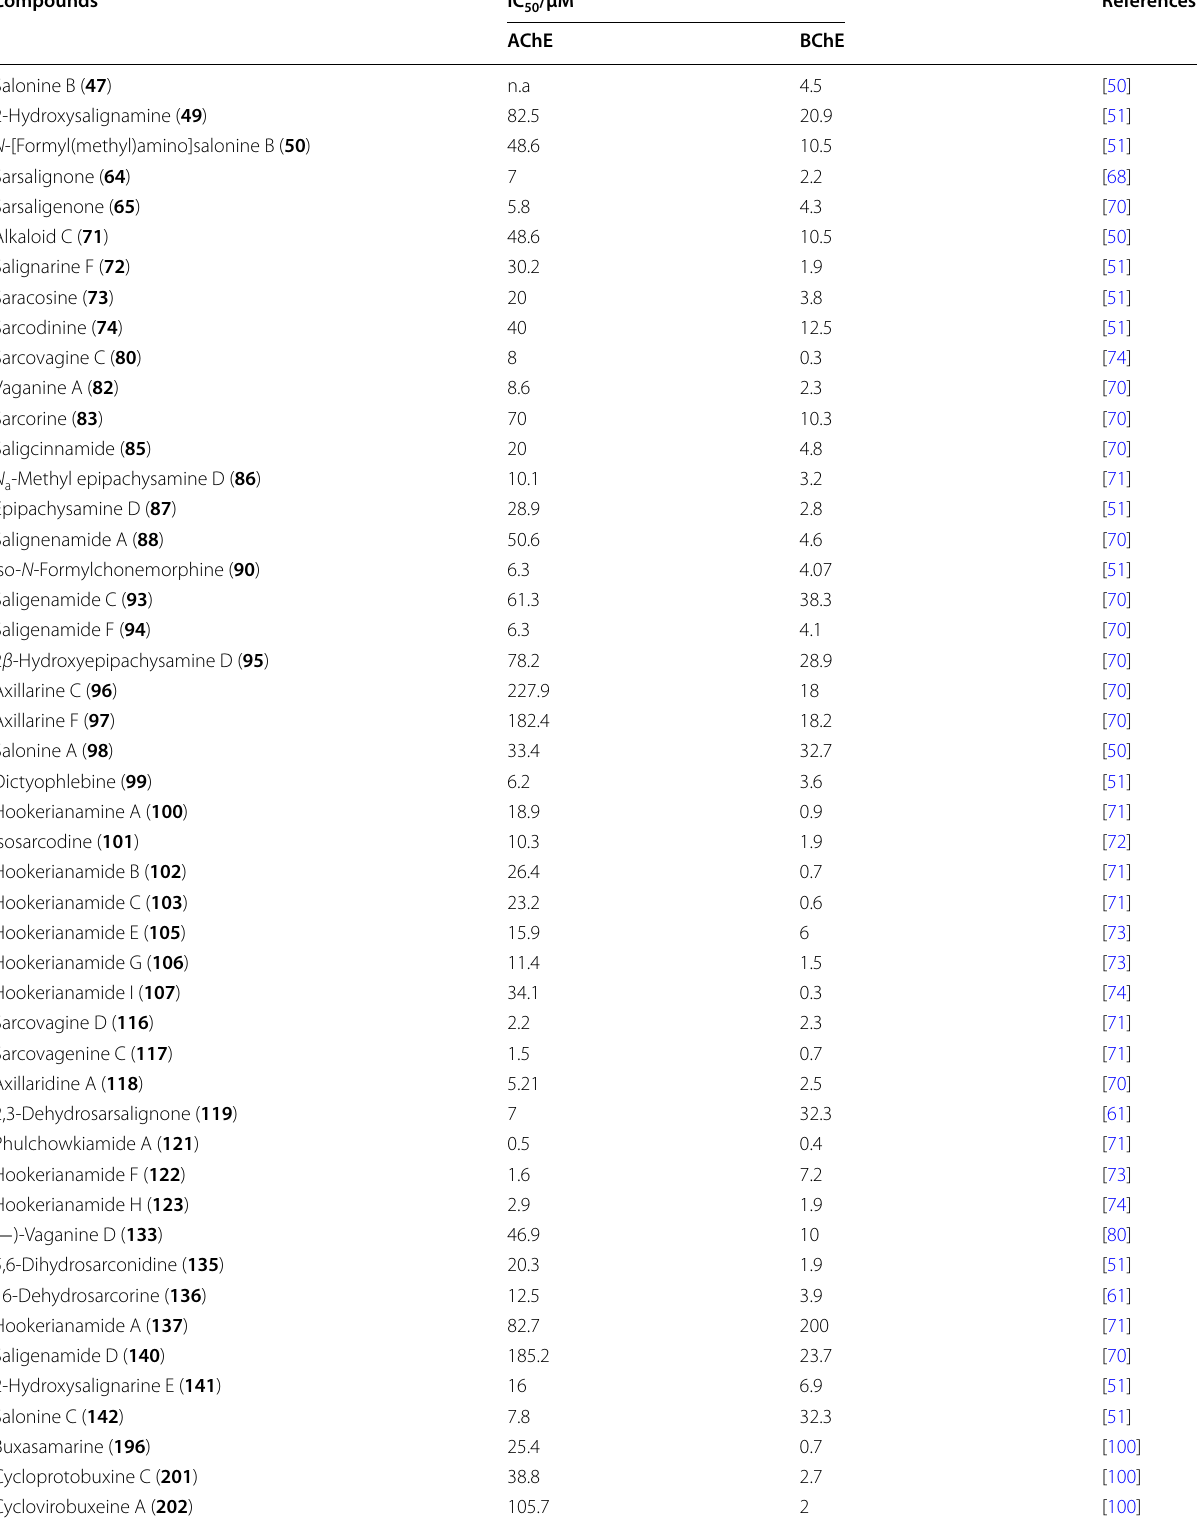
Table 19 Cholinesterase‑inhibiting activities of steroidal alkaloids Compounds IC 50